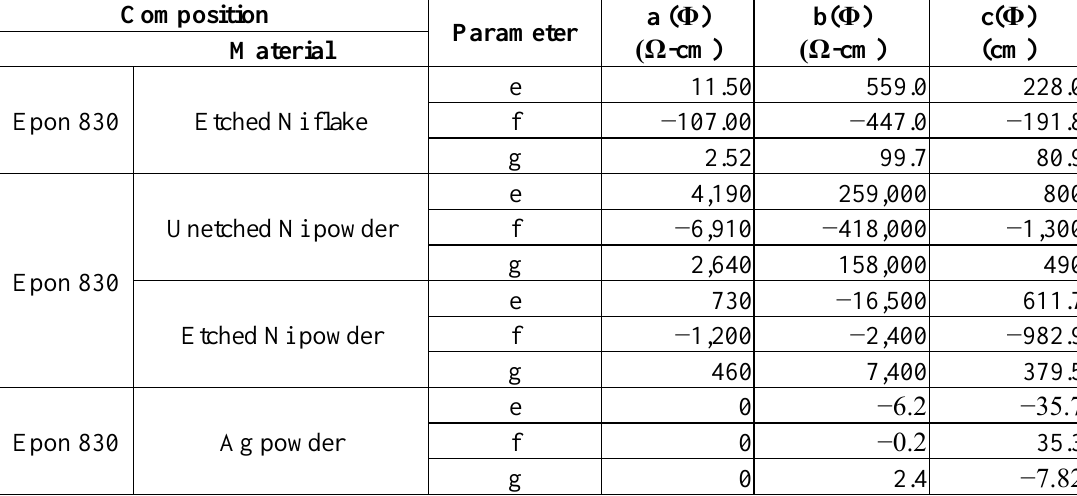
Table 6. The parameters e, f and g of Equation 18 for a(Φ ), b(Φ ) and c(Φ) with various filled Epon 830 adhesive